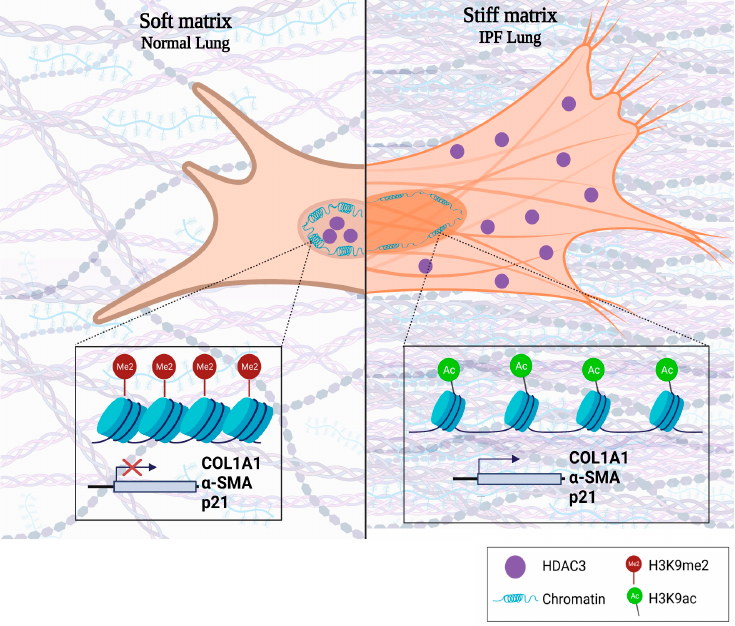
Figure 7. Created with BioRender.com. Matrix stiffness triggers the absence of HDAC3, chromatin remodeling, and fibroblast activation. HDAC3 is a mechanoresponsive protein crucial for maintaining compact chromatin and preventing gene expression by removing acetyl groups and increasing histone methylation. ( Left ) HDAC3 localizes mainly to the nucleus in a soft matrix and promotes peripheral compaction through its deacetylase function. ( Right ) In contrast, HDAC3 is exported to the cytoplasm in a rigid matrix, promoting hyperacetylation, more open chromatin, increased nucleus size, gene expression, and fibroblast